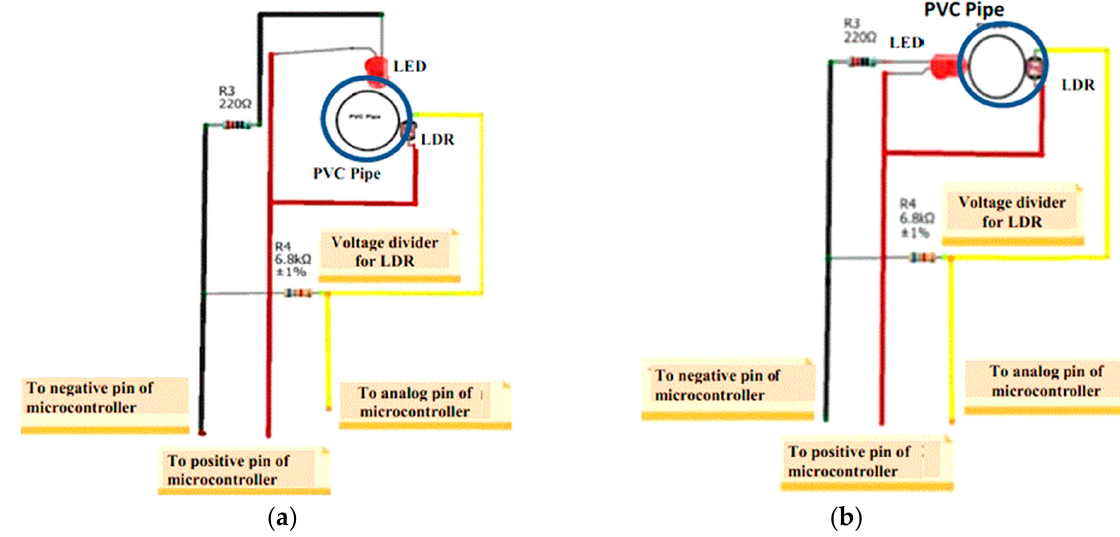
Figure 5. ( a ) Turbidity unit proposed for scenario 1 (180°); ( b ) Turbidity unit proposed for scenario 2 (90°) in [89] .